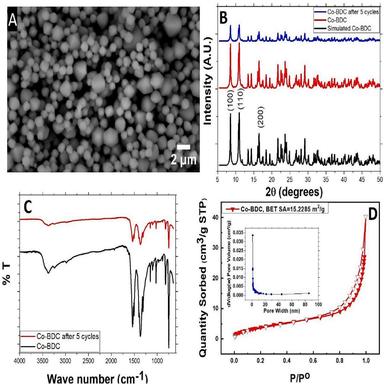
Co-BDC: (A) SEM, (B) XRD patterns, (C) FTIR, and (D) N2 adsorption isotherm and BET surface area (inset is pore size distribution curve).